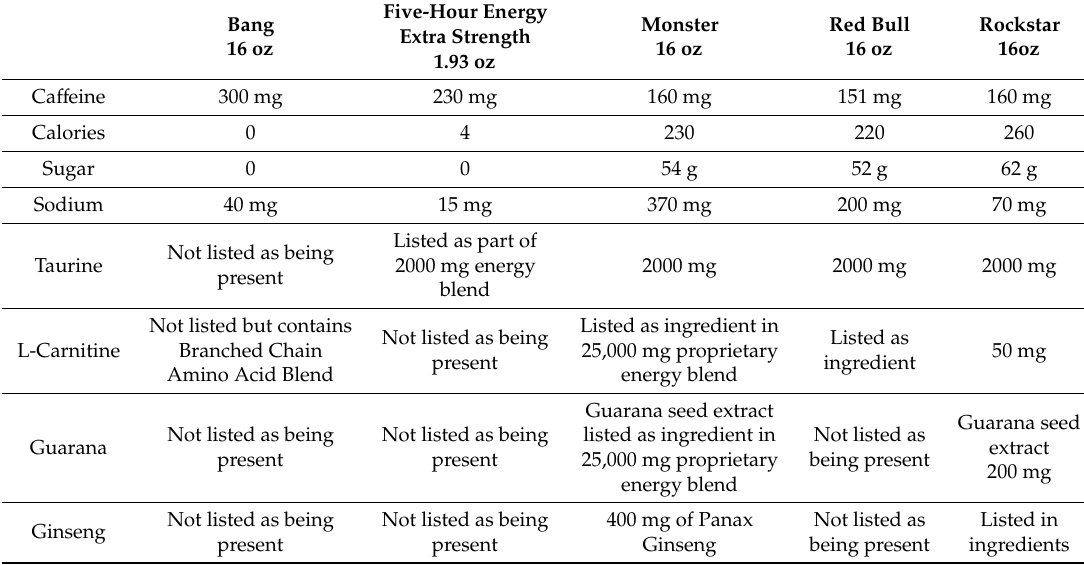
Table 1. Comparison of composition and ingredients in several popular energy